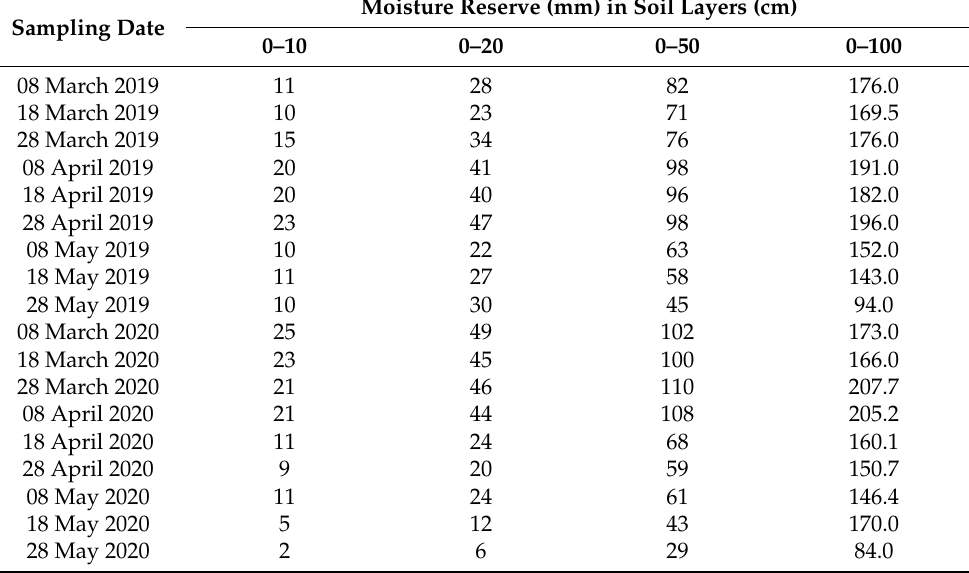
Table 5. Accumulated moisture reserves under winter wheat at various phases of the plant